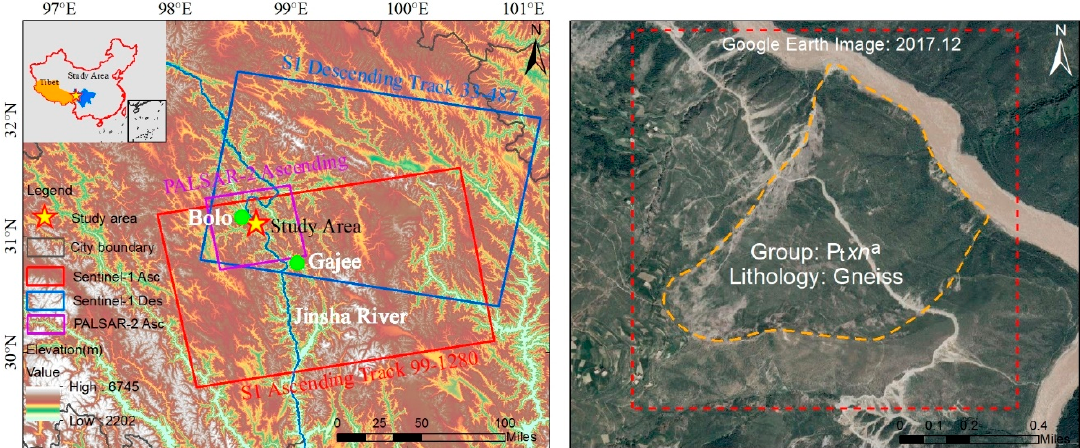
Figure 1. The location of the Xiaomojiu landslide. The backgrounds feature the DEM (digital elevation model) from SRTM and Google Earth images. Three orbits of SAR data are marked with red, green, and blue lines (background: modified from ESRI ArcGIS 10.7; © Google Earth 2021).